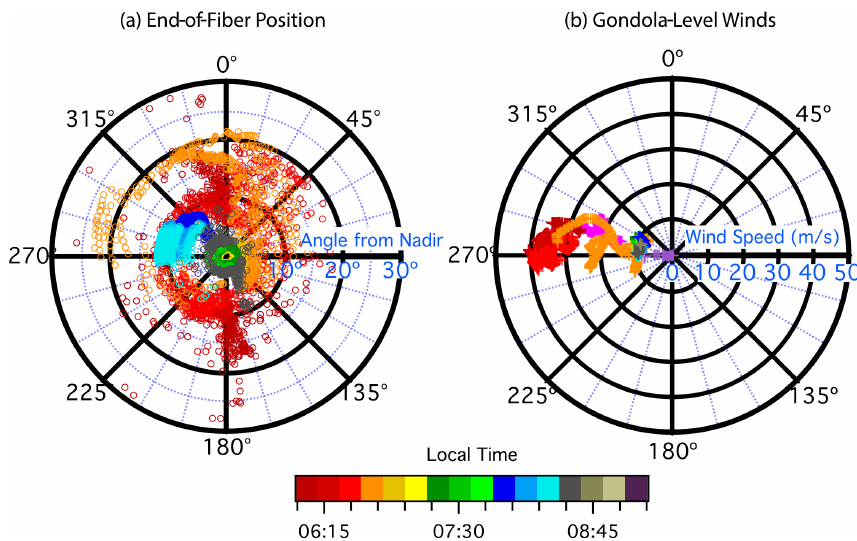
Figure 3. Polar graphs of (a) the end-of-fiber position angle in degrees with respect to nadir from the gondola and geographic bearing and (b) the wind speed in ms − 1 and wind direction in degrees observed at the gondola level. Markers (rainbow) are colored by the local time (MST).